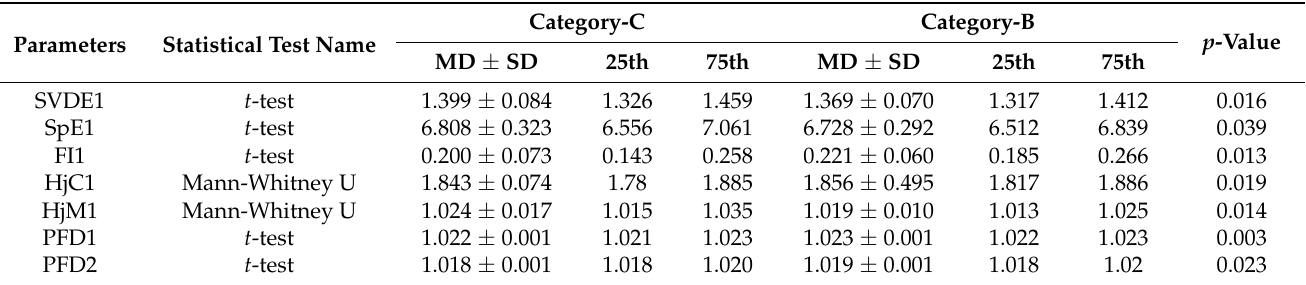
Table 3. Characteristics of statistically important parameters extracted from db02 mother wavelet- based level 2 decomposition of the HRV signals using DWT .